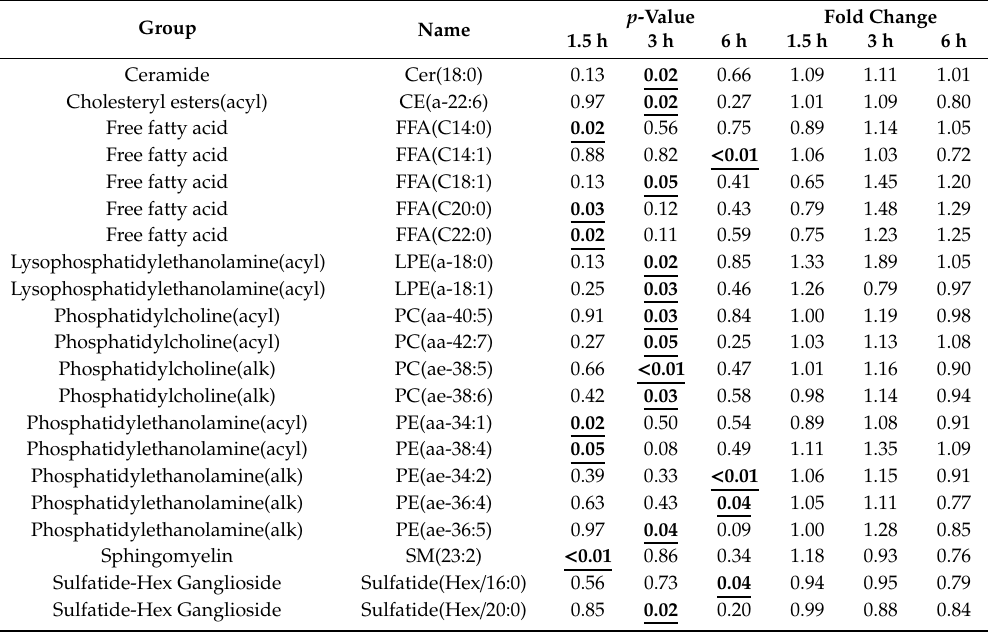
Table 2. Putative CSF lipids altered by the postprandial e ff